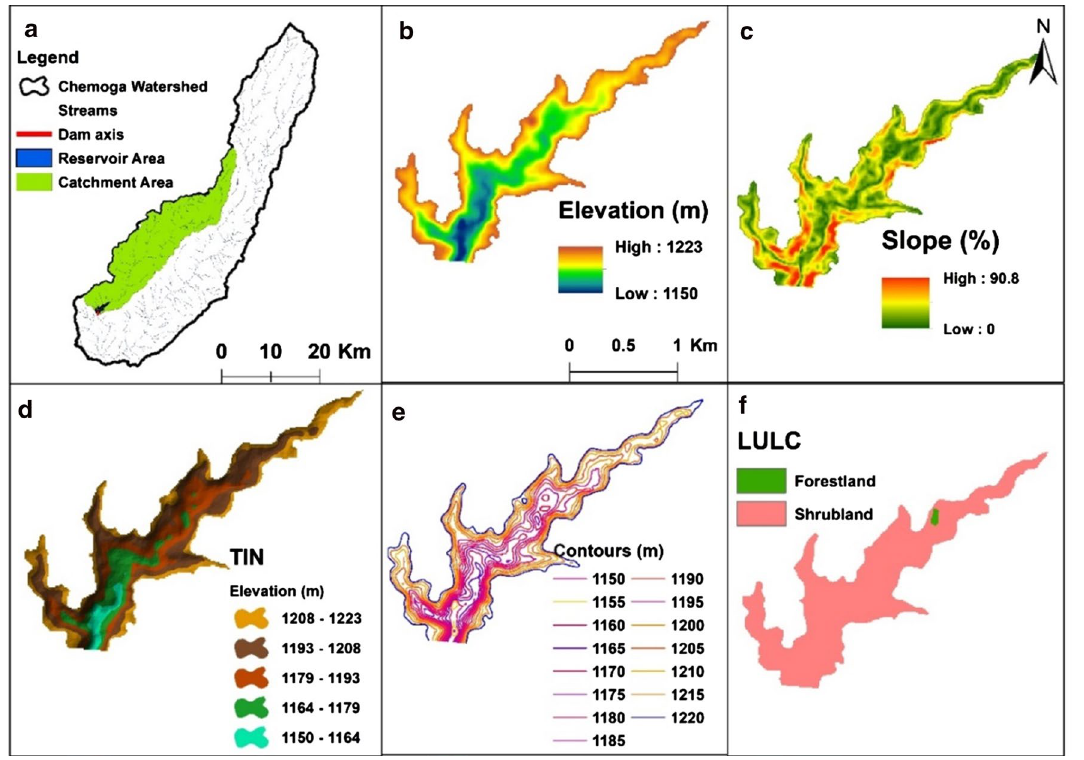
Fig. 18 Evaluation parameters for proposed Dam site 4: a Catchment area, b DEM, c slope, d triangulated irregular network (TIN), e contours, f